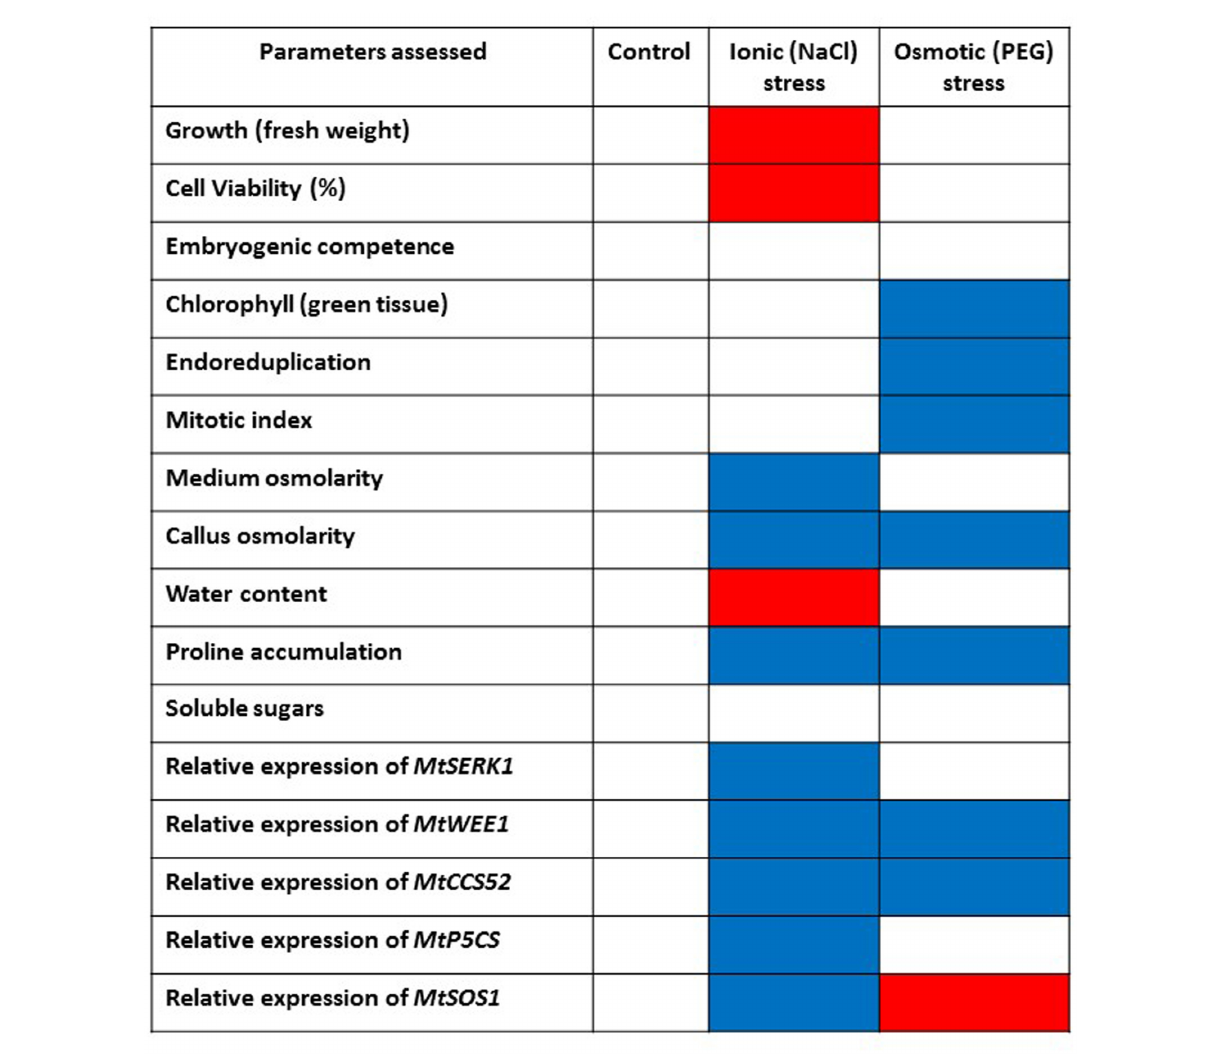
FIGURE 7 | Summarized effects on various parameters of imposing abiotic stress on embryogenic callus of M. truncatula following in vitro selection. Control callus tissues are compared with NaCl-tolerant callus (Elmaghrabi et al., 2013) and PEG-induced osmotic stress tolerant callus tissues in this study. Blue color indicates increase/upregulation. Red color indicates decrease/downregulation. When non-significant compared to controls white is